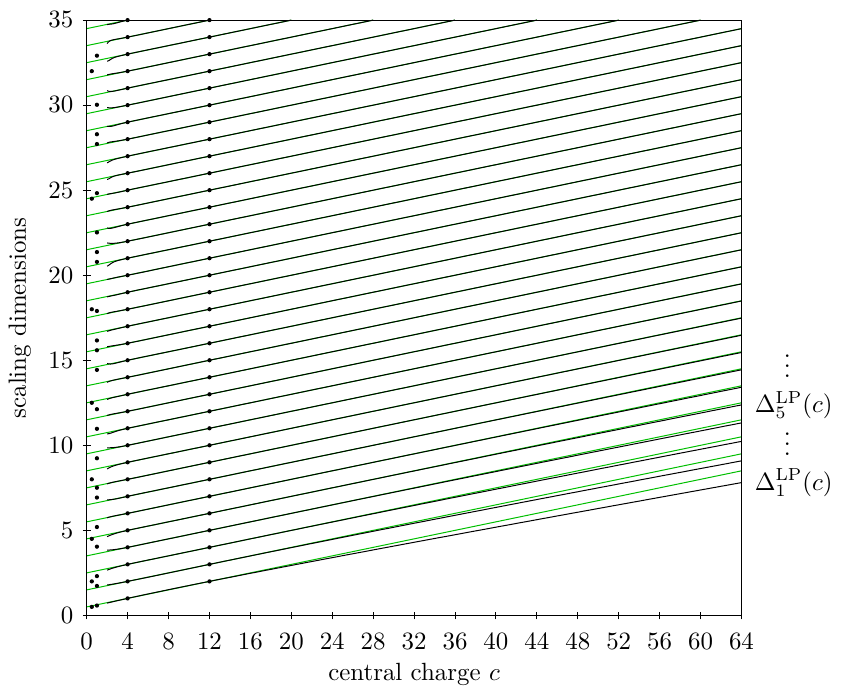
Figure 4 . The spectra ∆ LP ( c ) for 2 ≤ c ≤ 64 and c ∈ { 1 / 2 , 1 } , drawn in black. The dots highlight n the spectra for c ∈ { 1 / 2 , 1 , 4 , 12 } , and the green lines show the 1d generalized free fermion spectra.